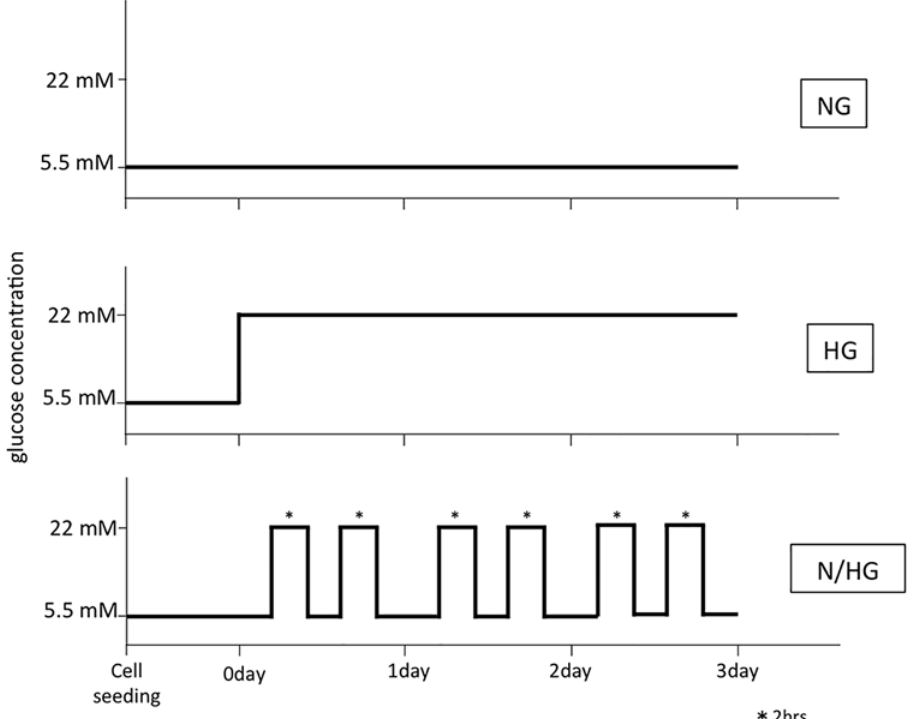
Fig 1. Research Design. The endothelial cells were exposed to the experimental condition for 3 days. They were grouped as follows: (1) constant normal glucose medium (5.5 mM:NG); (2) constant high glucose medium (22 mM: HG); and (3) alternating normal and high glucose media every 12 h